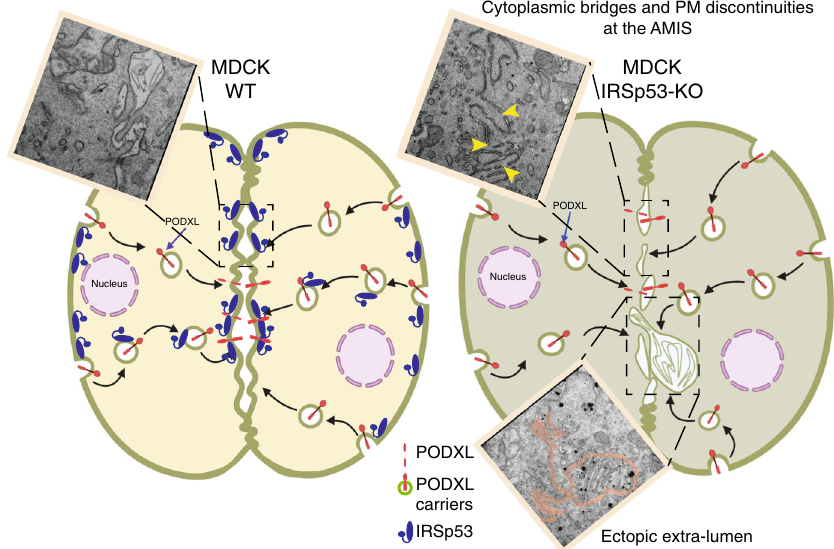
Fig. 10 Model of how IRSp53 controls nascent lumen formation in epithelial tubular tissues. Control MDCK cells plated on Matrigel in Matrigel- containing media undergo symmetry-breaking events immediately after the fi rst cell division, when after cytokinetic furrow ingression a midbody is formed 4 . Around the midbody, the apical membrane initiation site (AMIS) is assembled establishing the location of the nascent lumen. AMIS assembly requires the polarized transport of highly-charged and -glycosylated transmembrane proteins, such as Podocalyxin (PODXL), that from the outer cell face become endocytosed and traf fi c via vesicular recycling carriers to the newly formed opposing plasma membrane. At this site, repulsive charges contribute to generate interconnected mini-lumens (leftmost inset show a Correlative Light Electron Microscopy-CLEM-analysis of MDCK cells capture after the very fi rst cell division) that will evolve to form a single apical lumen, typical of an epithelial cyst. IRSp53 is required both for directing the traf fi cking of PODXL and to ensure its targeting at the AMIS via stabilizing the GTPase RAB35 (not shown), and through its interaction with the actin capping protein Eps8 (not shown). At the AMIS, IRSp53 through its membrane deforming and curvature sensing I-BAR domain ensures the structural integrity, continuity and correct shape of the opposing plasma membrane at two-cells stage. Consistent with this, IRSp53 genetic loss leads to interruption of the continuity of the PM at the AMIS (top rightmost inset, yellow arrowhead indicate membrane discontinuities), with the formation of inter-cytoplasmic bridges, and occasionally ectopic lateral lumen (bottom inset, magenta line outlines the intervening PM and the extra